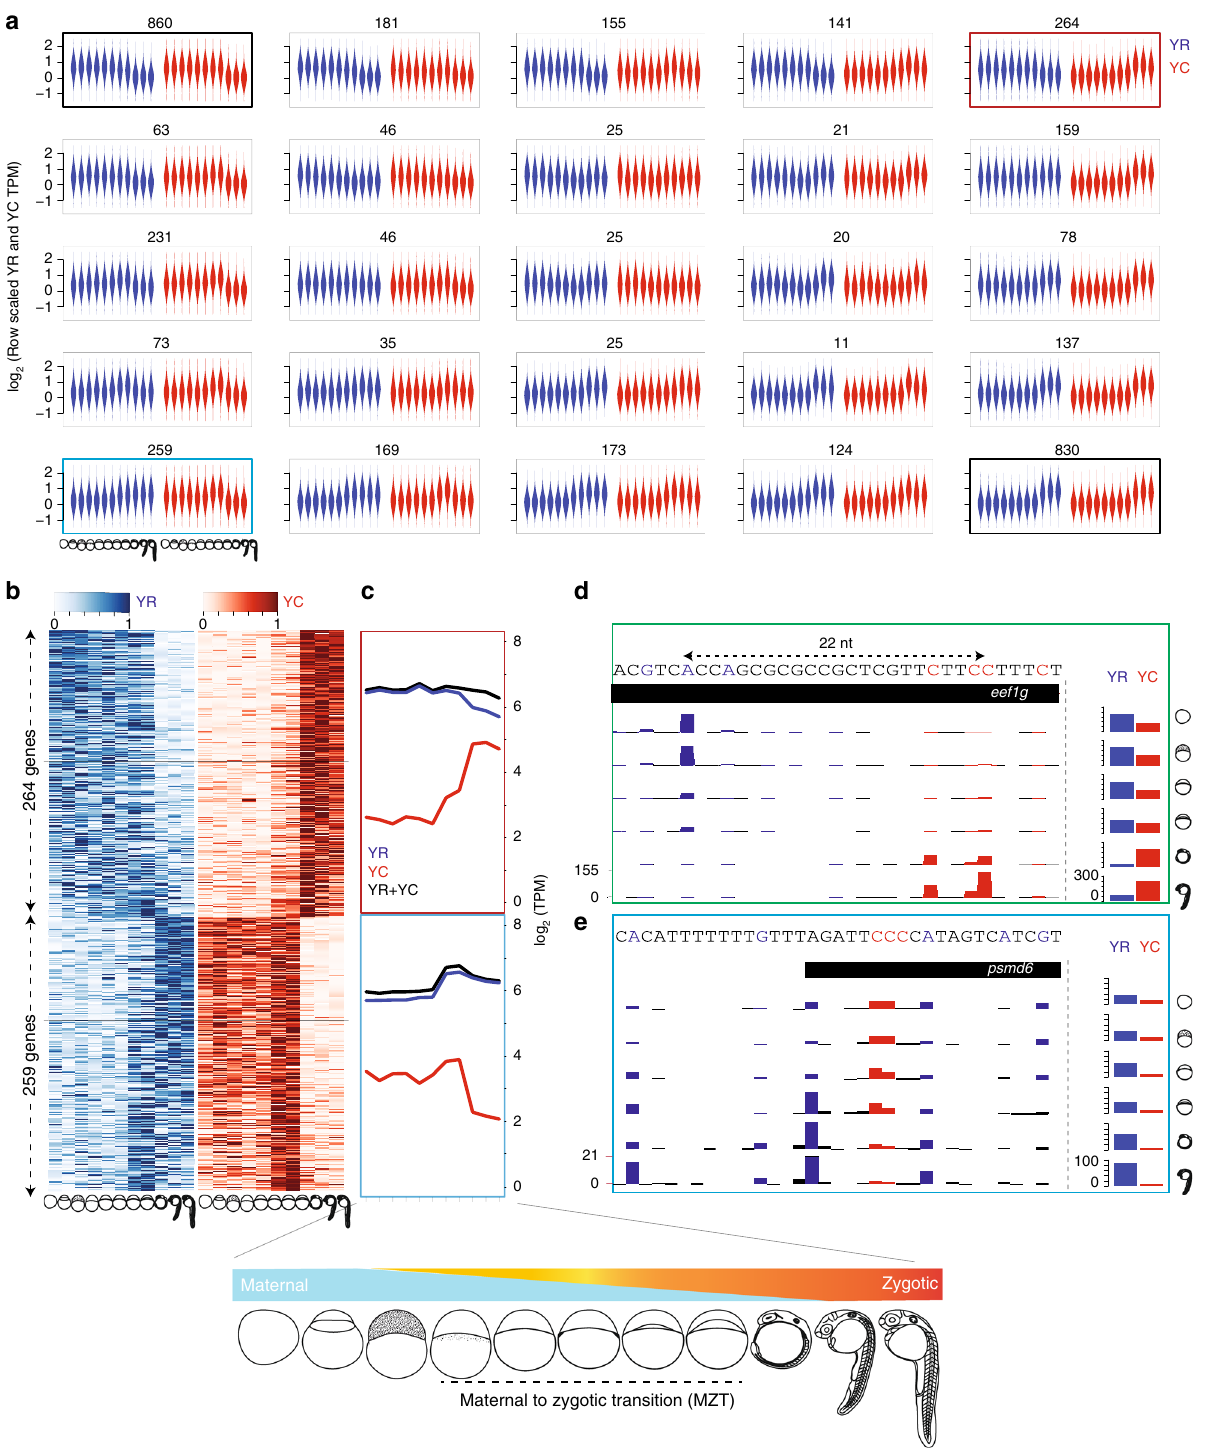
Fig. 3 Maternal to zygotic transition of YR-initiation and YC-initiation. a Violin plot of expression pro fi les (tags per million) of YR and YC components of genes during embryo development clustered by Self Organizing Map (SOM) analysis. Blue and red colors indicate YR and YC components respectively. X - axis represents developmental stages as indicated. Y -axis indicates expression levels scaled between YC and YR components separately. Numbers indicate genes in the cluster. b Heatmap rows show the gene expression pro fi les with YR and YC-initiation of selected SOM clusters indicated by the gene numbers on the left. Expression values are scaled row-wise between 0 to 1, separately for YR and YC. Genes are ranked by statistical signi fi cance of anticorrelation. Black line indicates signi fi cance threshold ( − 0.5). c Averaged expression level of total (black) YR-initiation (blue) and YC-initiation (red) across the clustered group of genes shown in b . d , e UCSC genome browser views of CTSSs for the eef1g and psmd6 gene promoters. Barplots on the right shows the sum of CTSSs of YR-initiation and YC-initiation events respectively. Distance between dominant YC and YR-initiation is indicated in d